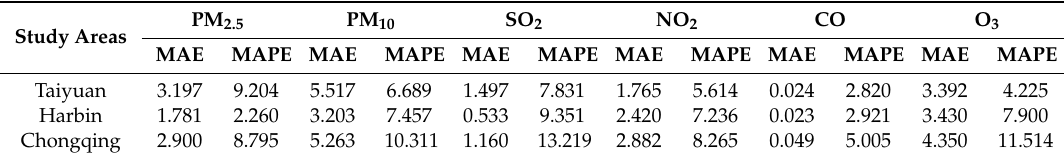
Table 20. Forecast results of ICEEMD-SVM-WOA model in three study areas.